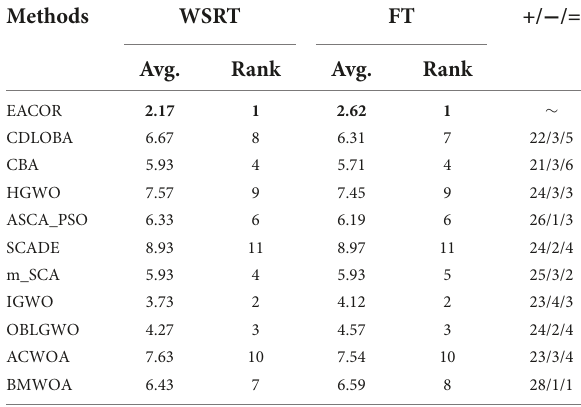
Table 7 shows the ranking of EACOR with these ten peers for both statistical methods. EACOR performed best in WSRT and FT, with an average ranking of 2.17 and 2.62,